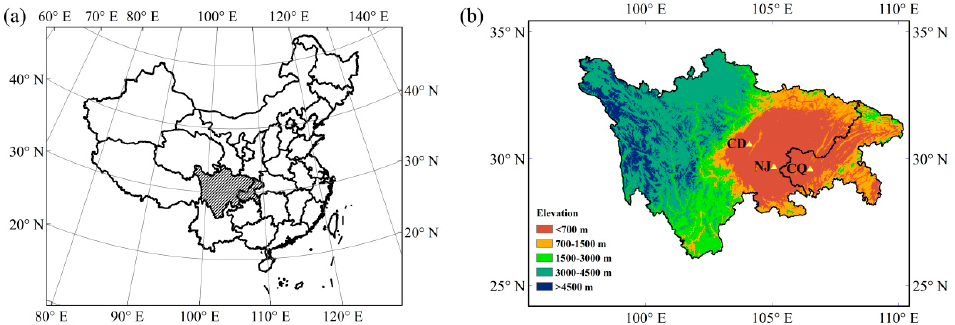
Figure 1. ( a ) Location of Sichuan and Chongqing in China; ( b ) Sampling sites of Chengdu (CD), Neijiang (NJ), and Chongqing (CQ).